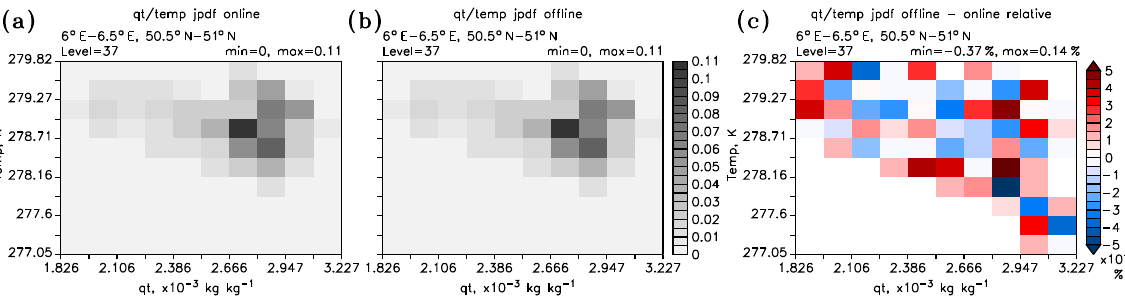
Figure 3. Joint PDF of water mixing ratio and temperature on 24 April 2013, 01:00:00UTC simulation time on model level 37 (approx. 1800m) in grid box 6.0–6.5 ◦ E, 50.5–51.0 ◦ N. (a) Output of online calculation from GRAGG, (b) offline calculation from 3-D ICON model output, (c) relative difference between offline and online calculated